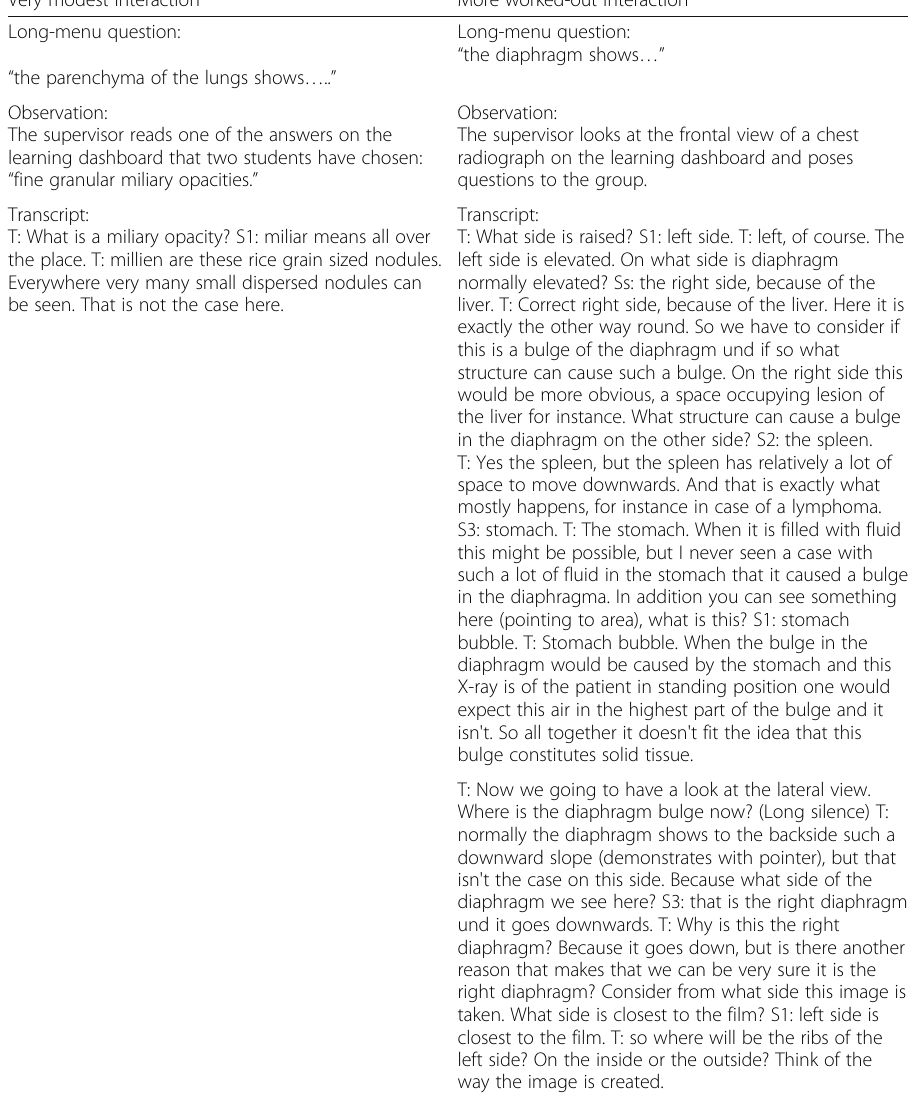
Table 2 Examples of verbal interactions during class-wide discussions on systematic viewing tasks Very modest interaction More worked-out